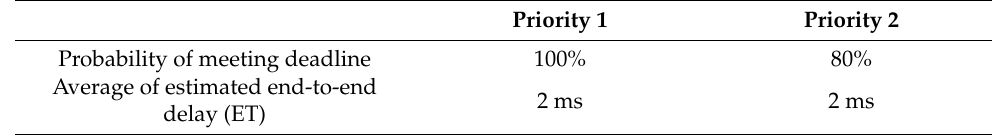
Table 2. Probability of meeting the deadline of each priority in